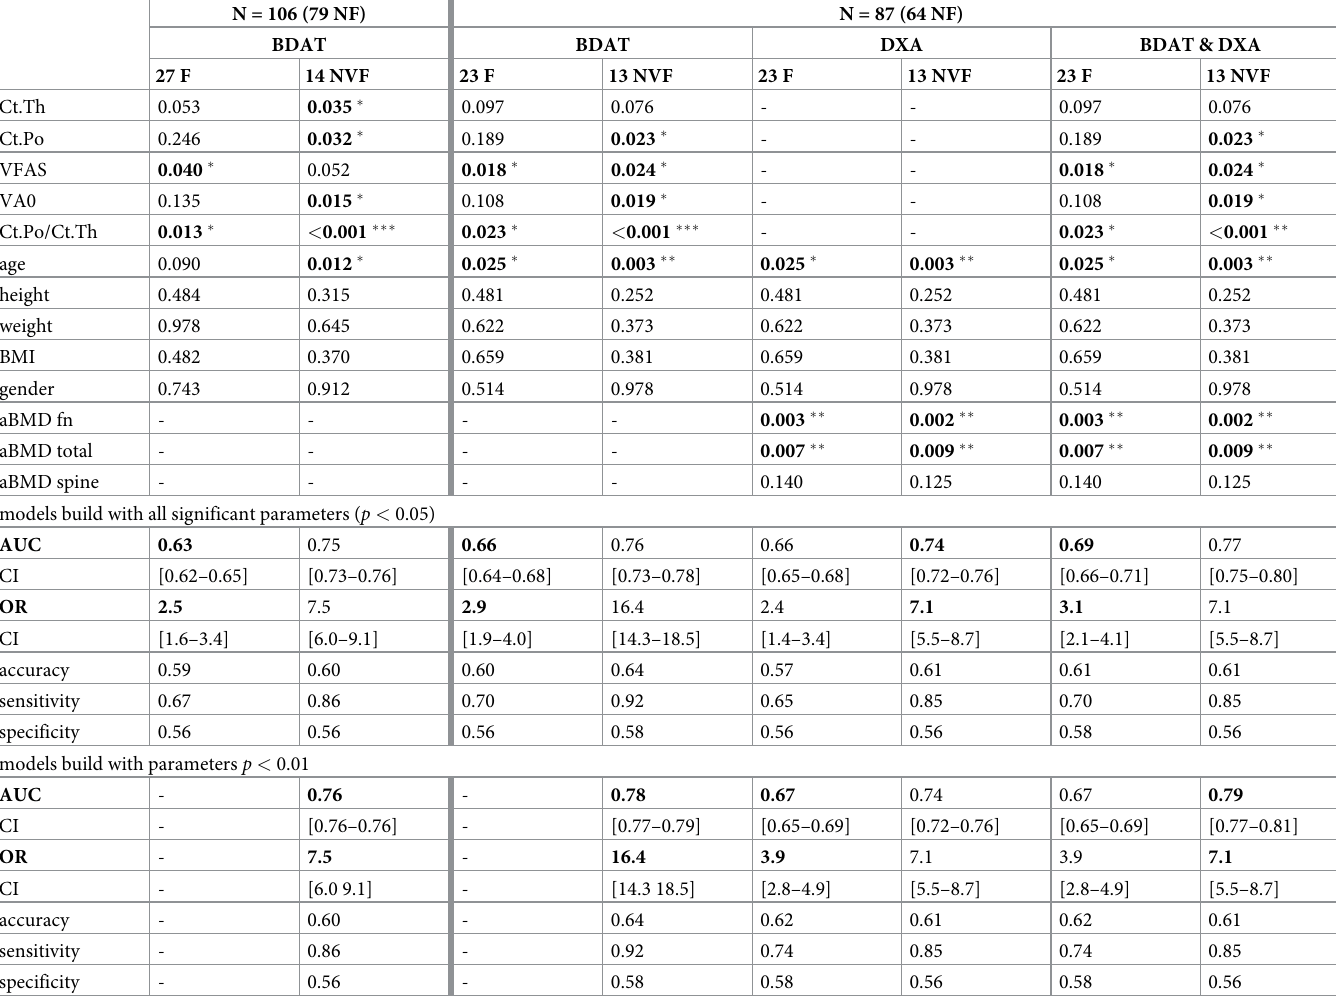
Table 4. Discrimination obtained with PLS-LOOCV: p values, odds ratios (OR) and areas under the ROC curve (AUC) for both BDAT and DXA techniques for the two populations (106 and 87 patients). N = 106 (79